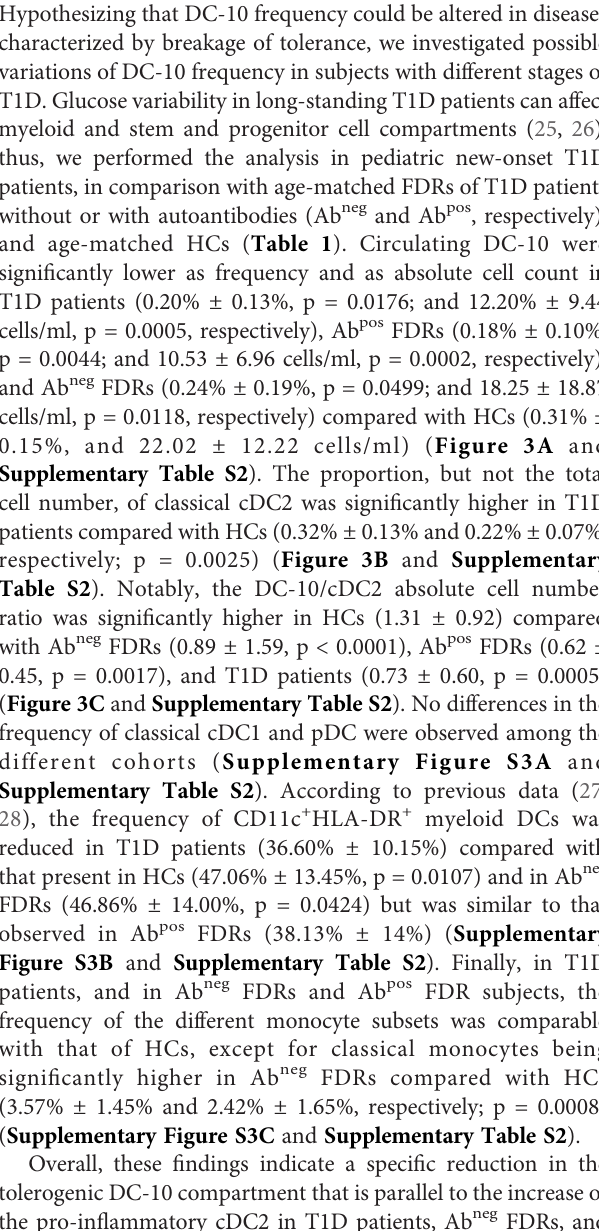
subsets analyzed.